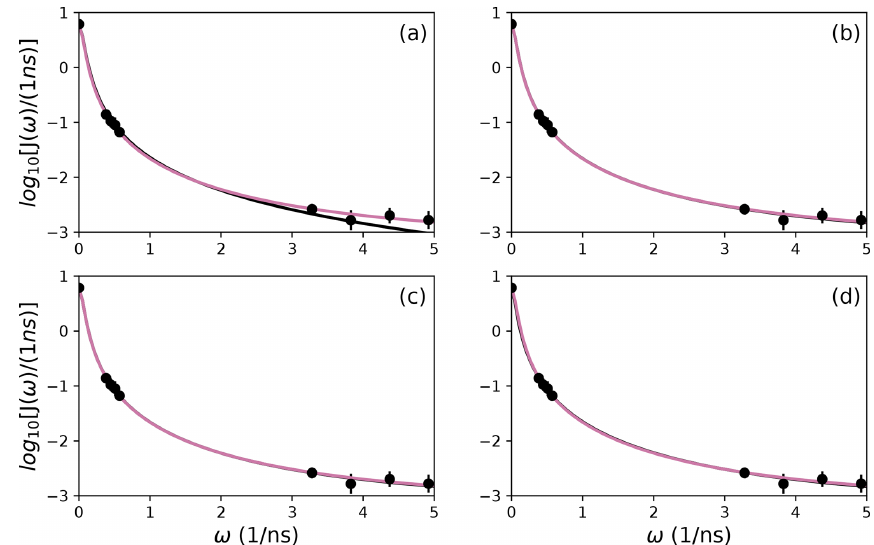
Figure 11. Comparison of individual fits for Asp 32 of (a) Model 1, (b) Model 3, (c) Model 4, and (d) Model 5 (black lines) or the bootstrap aggregation smoothed fit (reddish-purple line) to (circles) experimental spectral density